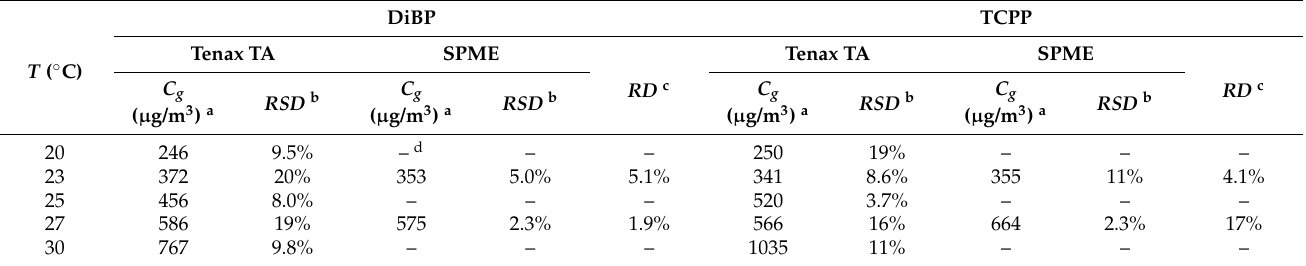
Table 1. Comparison of the gaseous concentrations ( C g ) of DiBP and TCPP measured by the sorbent tubes (packed with Tenax TA) with those measured by the SPME-based active